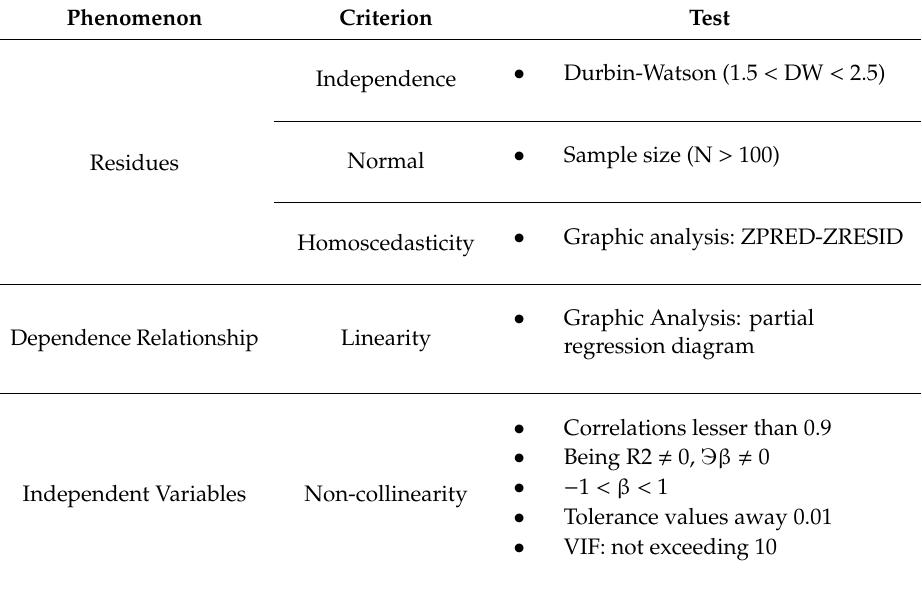
Table 2. Conditions for the application of linear regression models.